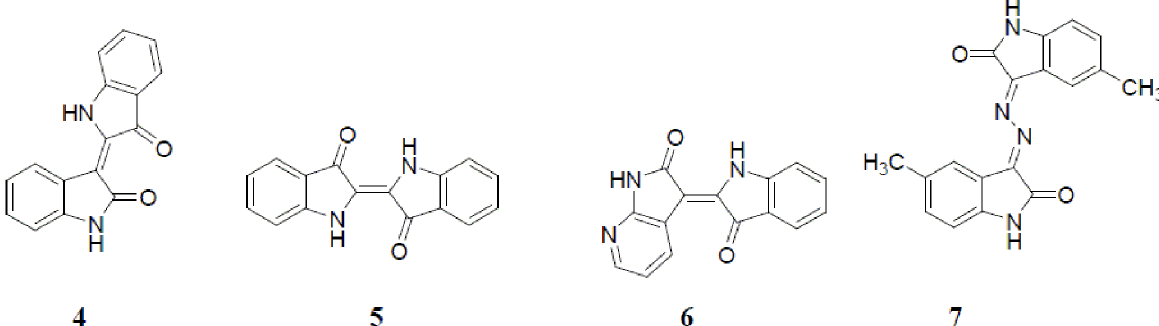
Fig 2. Chemical structuresof some bioactive bis-isatin